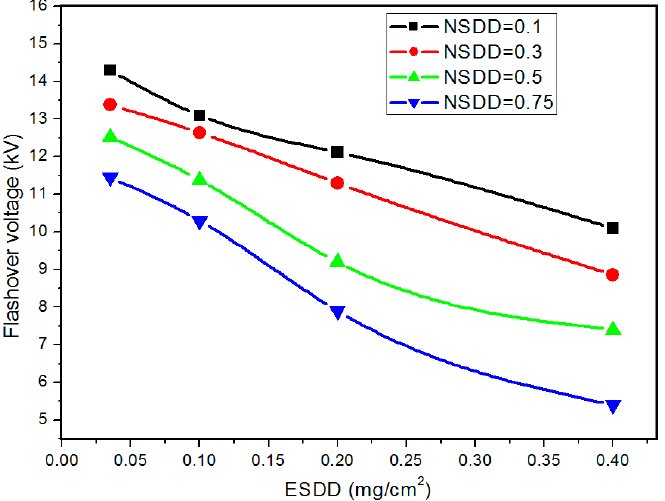
Figure 13. Flashover voltage at different NSDD levels, where pollution distribution = uniform, humidity level = low, temperature = 10 °C, and standard deviation = 2.3%–7.2%.